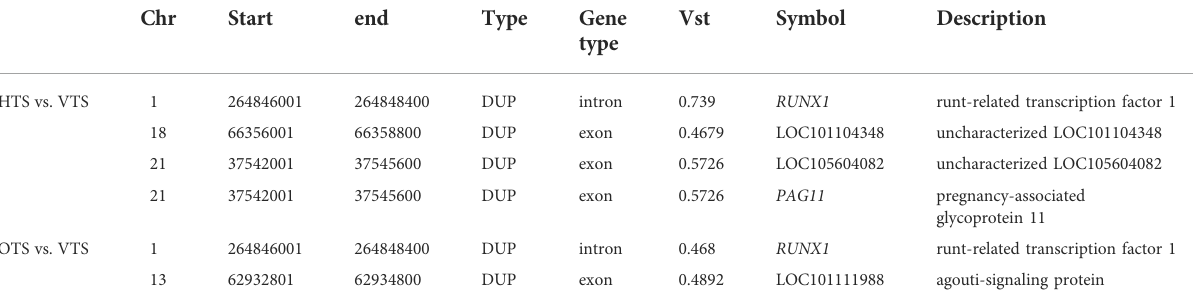
TABLE 3 CNVR-harboring genes showing high divergence in two population pair